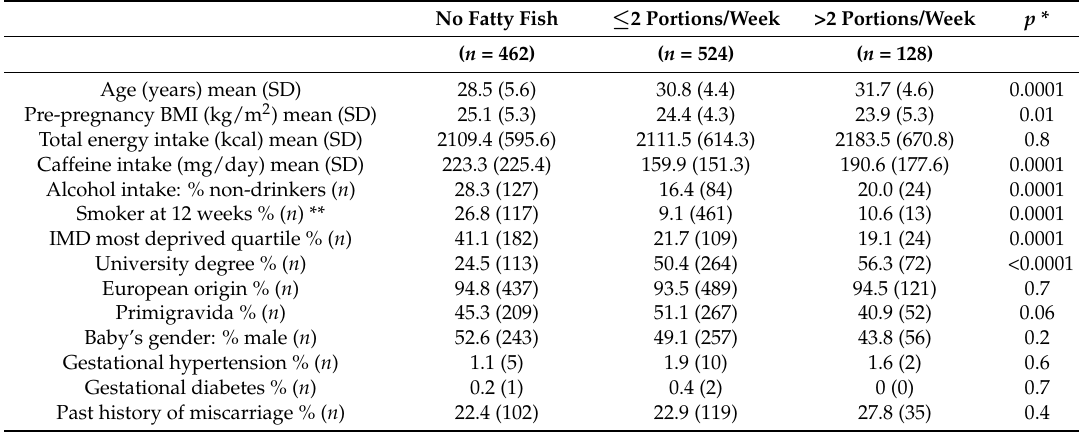
Table 2. Characteristics of mothers by fatty fish intake in the 1st trimester of pregnancy ( n = 1114). No Fatty Fish ≤ 2